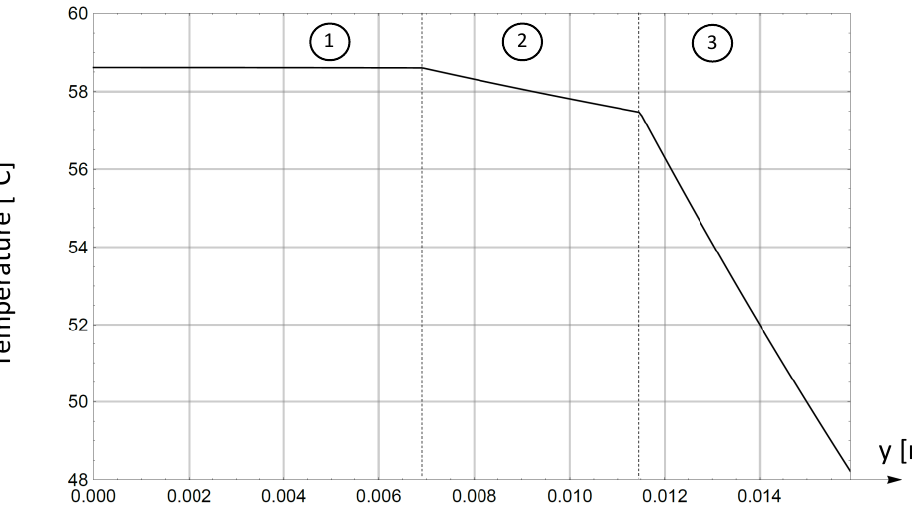
Figure 6. Temperature change in the test model on semi-axis x = 0 (for I cr = 553.51 A ).